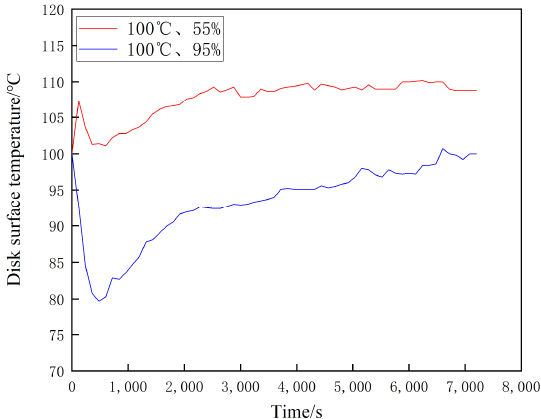
Figure 24. Variation of disc surface temperature at 20 °C under different ambient humidities.